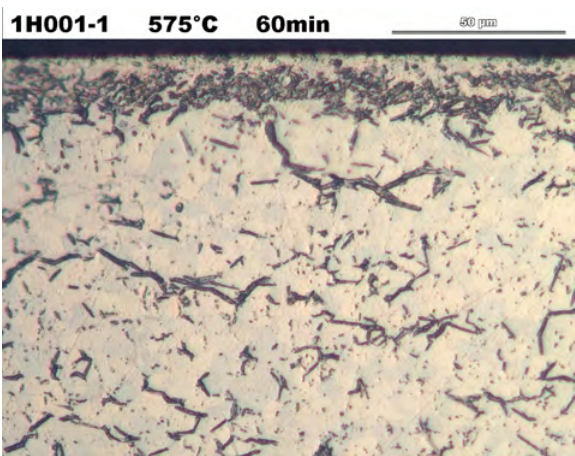
Figure 10. Sample 1H001, section 1, detail B. After hydrogen charging was used annealing at temperature 575 ◦ C and 60 minutes of time duration.